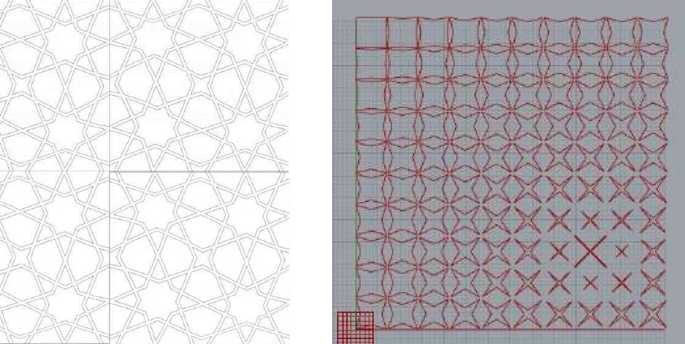
Figure 16. Design evolution of the parametric dynamic façade.